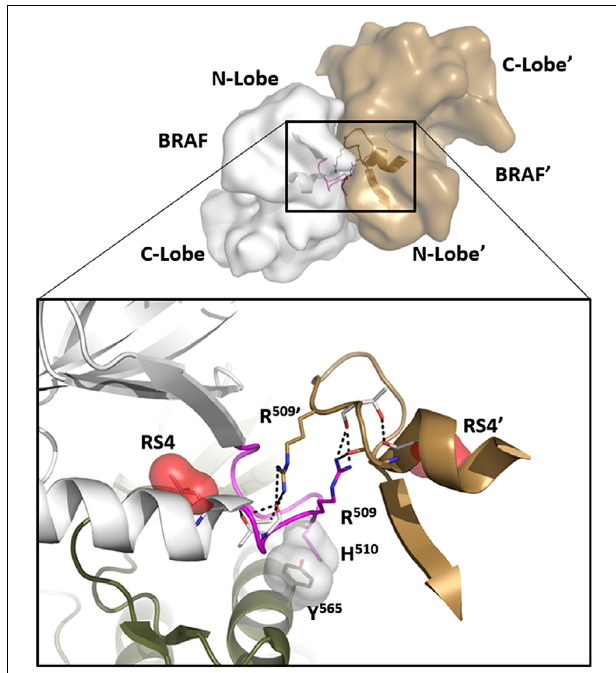
FIGURE 4 | The α C- β 4 Loop in BRaf is a dimer interface. At the top is the anti-parallel BRaf dimer. The close-up view of this interface (bottom) shows how R509 in the α C- β 4 Loop drives dimer formation and mutating this Arginine breaks the dimer. R509 in BRaf is homologous to H1928 in LRRK2. Another key interaction that is conserved in all kinases is the anchoring of the α C- β 4Loop to the α E-Helix through a conserved hydrophobic Tyr or Phe (Y565).